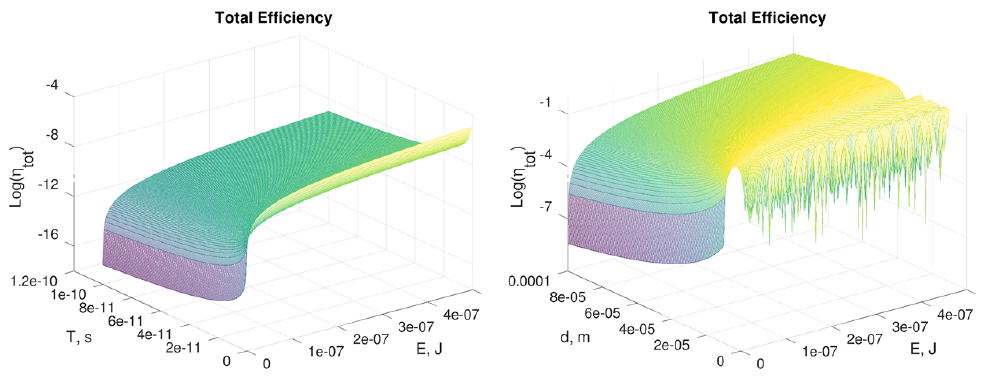
Figure 7. Left : Log ( η tot ) vs. E,T; right : Log ( η tot ) vs. E,d.